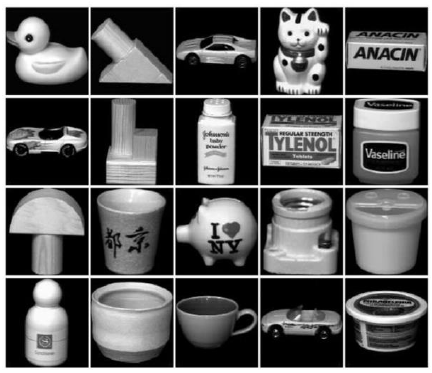
Figure 2. Typical examples of the COIL20 dataset. Table 2. Segmentation results of proposed and existing algorithms on the COIL20 dataset. Clusters